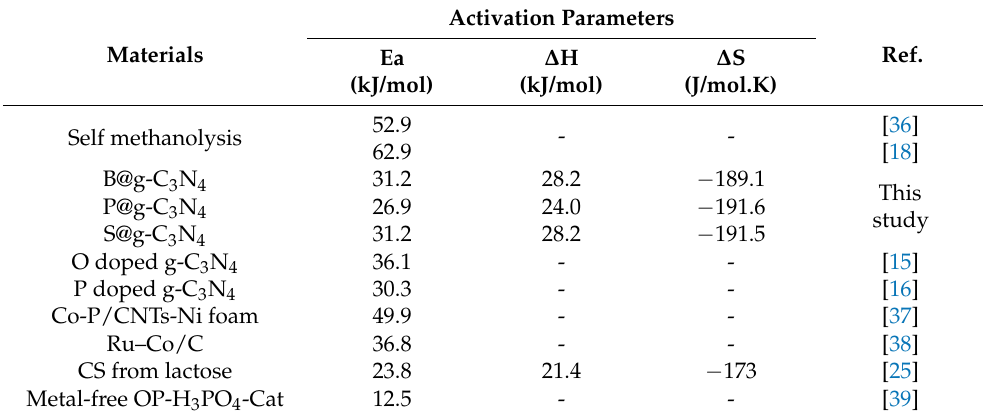
Table 1. The calculated Ea, ∆ H, and ∆ S values for H@g-C 3 N 4 -catalyzed (H: B, P, or S) dehydrogena- tion reactions of NaBH 4 in methanol and in comparison with reported